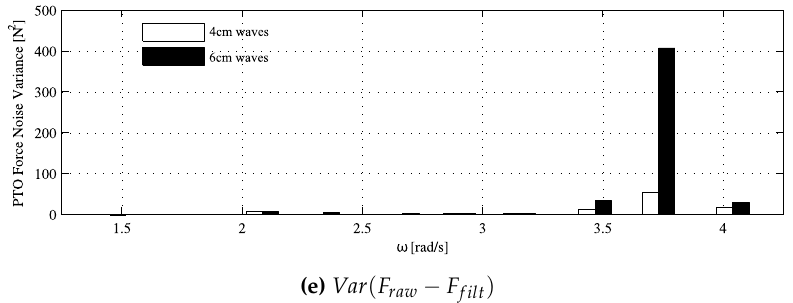
Figure 5. PTO force time series in regular waves of frequency ( a ) ω = 3.15 rad/s ( b ) ω = 3.70 rad/s. The “commanded” and “measured” signals are the reference force and the measured force output of the PTO, respectively. Plots ( c ) and ( d ) are the error time series between the measured and commanded force signals, normalized by the maximum of the commanded force time series; ( e ) variance of the PTO Force Noise Var ( F raw − F filt ) as a function of frequency for 4 cm and 6 cm wave heights. F filt is F raw post-processed through a 124th order, low pass filter with 8 rad/s cut-off.